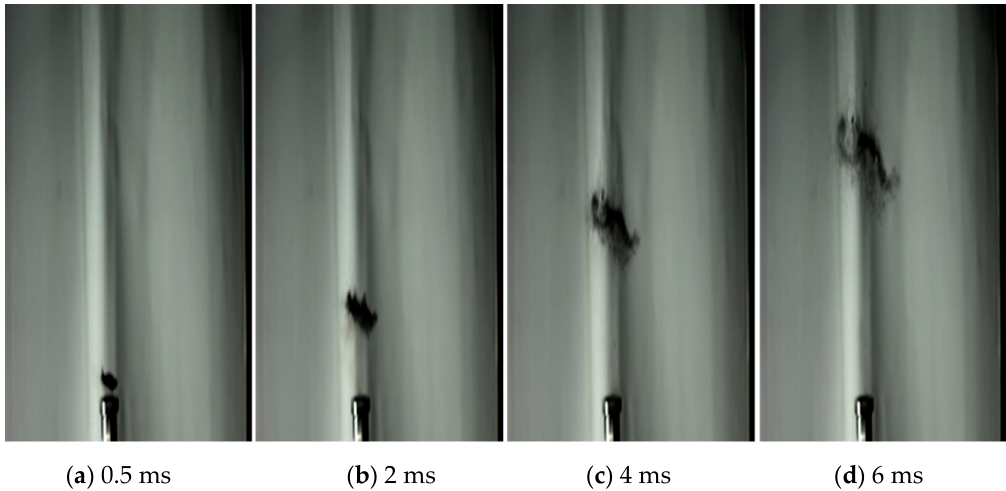
during the experiment. ( a ) at 0.5 ms; ( b ) at 2 ms; ( c ) at 4 ms; ( d ) at 6 ms.